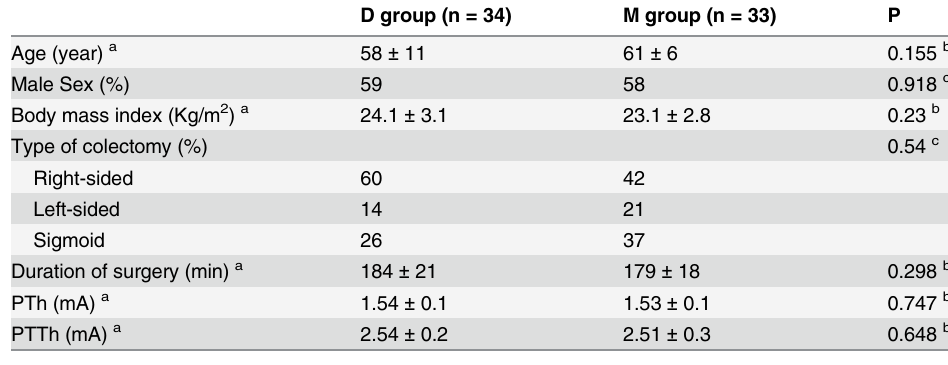
Table 1. Baseline characteristics and surgical aspects of the included patients in both the